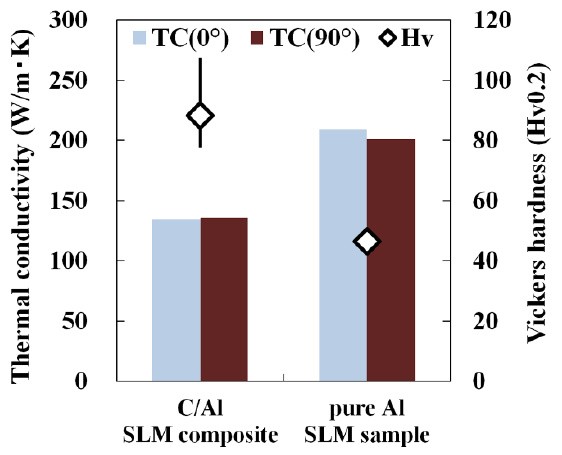
Figure 9. Vickers hardness (shown in points) and thermal conductivity (shown in bars) of the optimally processed material (C/Al SLM composite) and pure Al SLM sample.